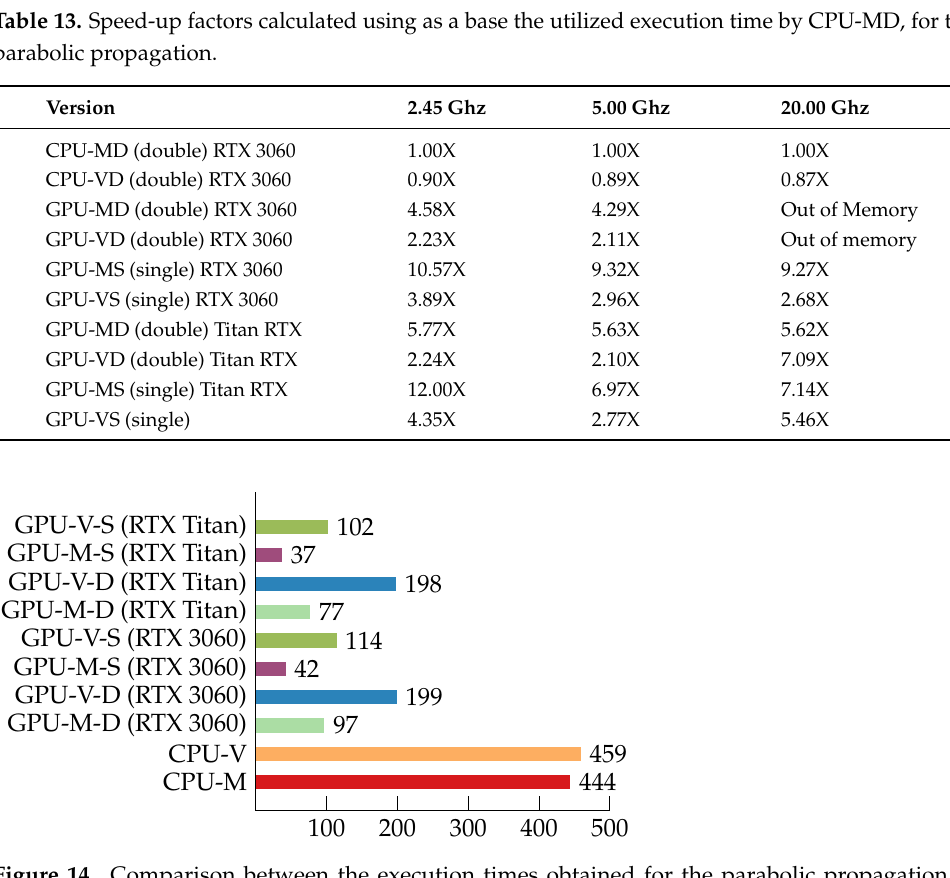
Figure 14. Comparison between the execution times obtained for the parabolic propagation at 2.45